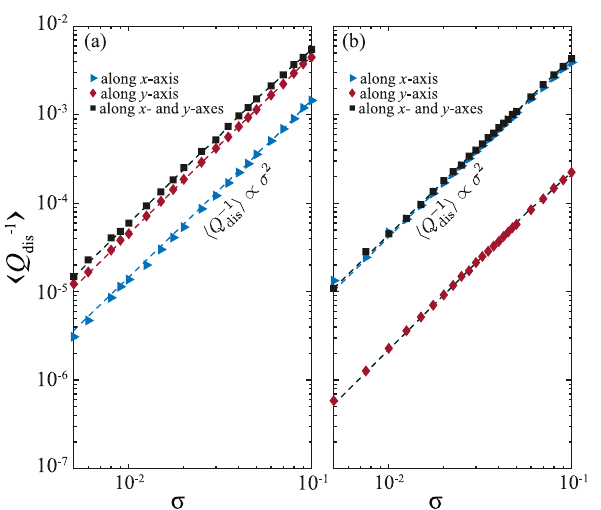
increases slowly, the frequencies of the mode 1 and mode 2, at which the accidental BICs occur, exhibit complicate behavior.